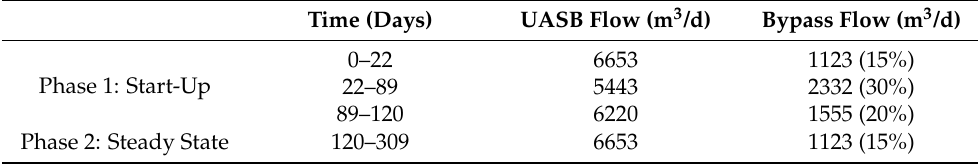
Table 3. Influent flow to the UASB and the bypass during the evaluation period.